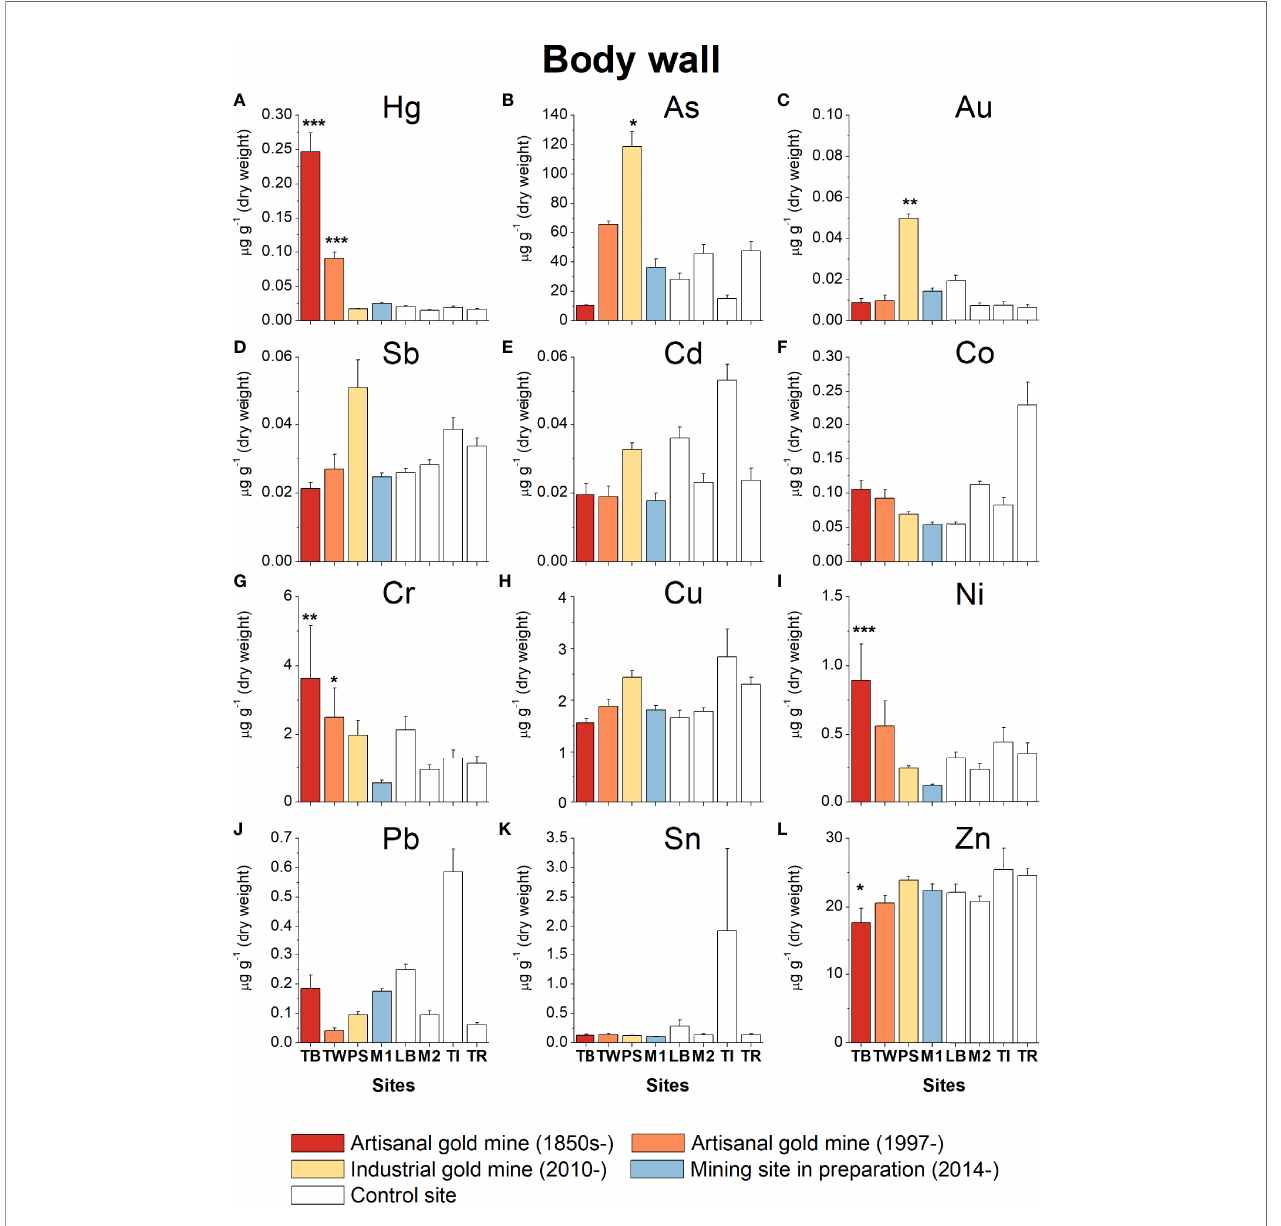
FIGURE 4 | Mean concentrations (± s.e.) in H. atra body wall of Hg (A) , As (B) , Au (C) , Sb (D) , Cd (E) , Co (F) , Cr (G) , Cu (H) , Ni (I) , Pb (J) , Sn (K) and Zn (L) at each study site (TB, Totok Bay; TW, Talawaan River; PS, Pantai Surabaya; M1, West Bangka mangroves; LB, Lihunu Bay; M2, North-west Bangka mangroves; TI, Tumbak Island; TR, Tasik Ria Resort). Impact sites that differ signi fi cantly from controls are marked with asterisks: * p < 0.05; ** p < 0.01; *** p <